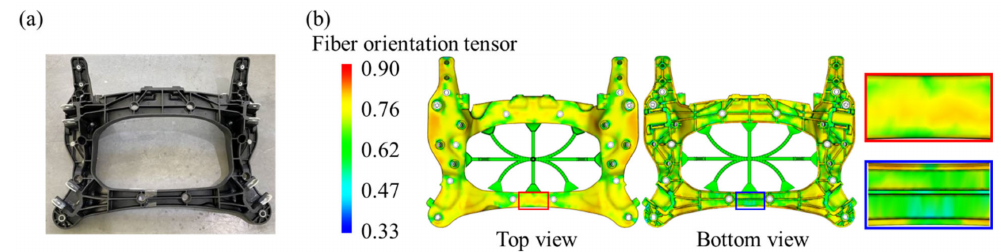
Figure 19. ( a ) PA6-20CF composite cross-member with aluminum insert fabricated by injection molding (bottom view), ( b ) fiber orientation distribution result of the cross member and detailed view at the machined